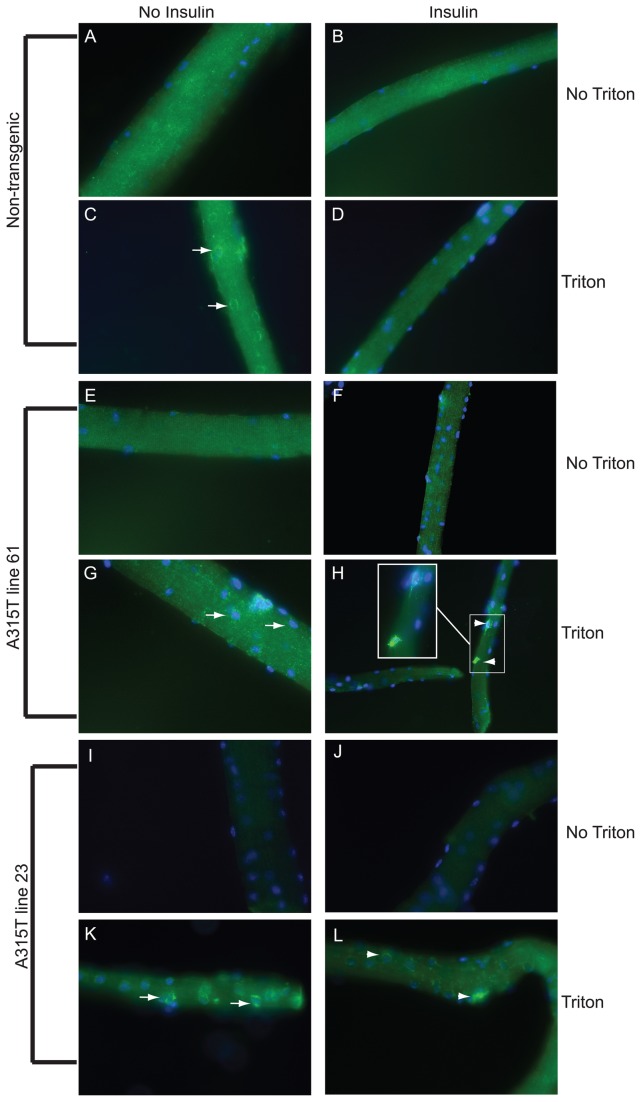
Glut4 translocation assay in isolated flexor digitorum brevis muscle.(A–L) Glut4 immuno-reactivity in FDB fibers from non-transgenic mice (A–D), A315T line 61 (E–H), and A315T line 23 (I–L). Arrows highlight peri-nuclear Glut4 containing vesicles without insulin treatment. Arrowheads indicate dense accumulation of Glut4 immuno-reactivity with insulin treatment. Mice were 8-12 weeks of age. Magnification =400x, except for (H) which is 200X (insert =400X).